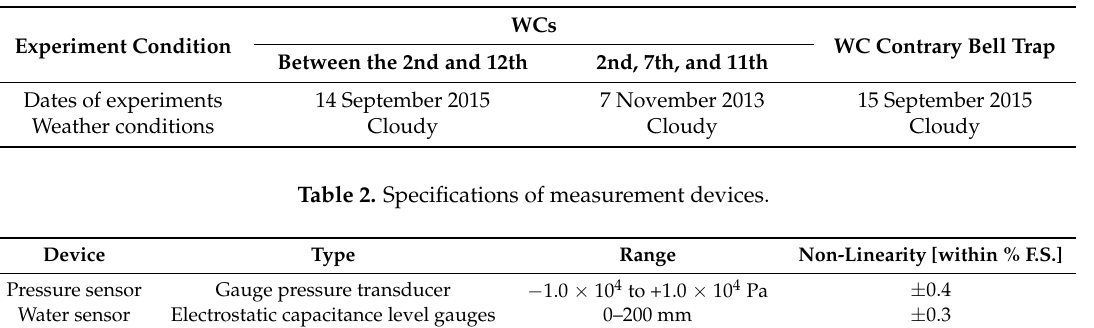
Table 1. Dates of experiments and weather conditions.